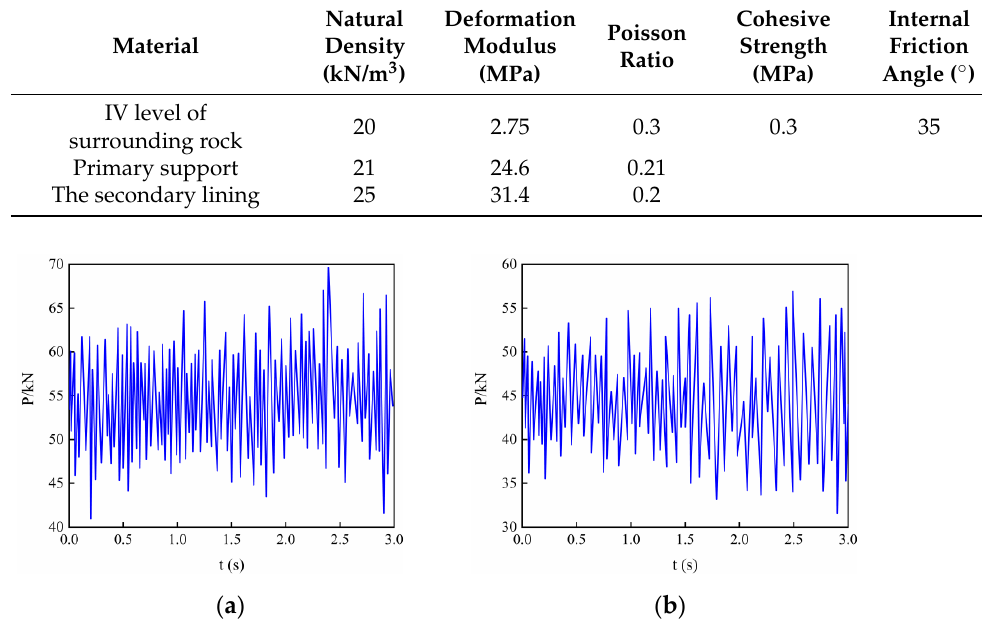
Figure 6. Numerical model. Table 4. Main parameters of model material.